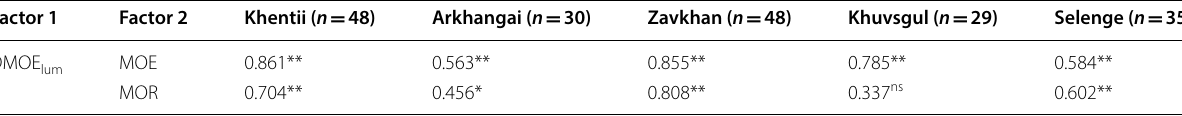
n : number of lumber; DMOE lum : dynamic Young’s modulus of lumber; MOE: modulus of elasticity; MOR: modulus of rupture; ns: no significance